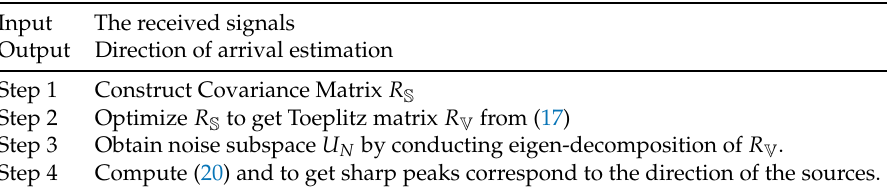
Table 1. Active Coarray Interpolation (ACI)